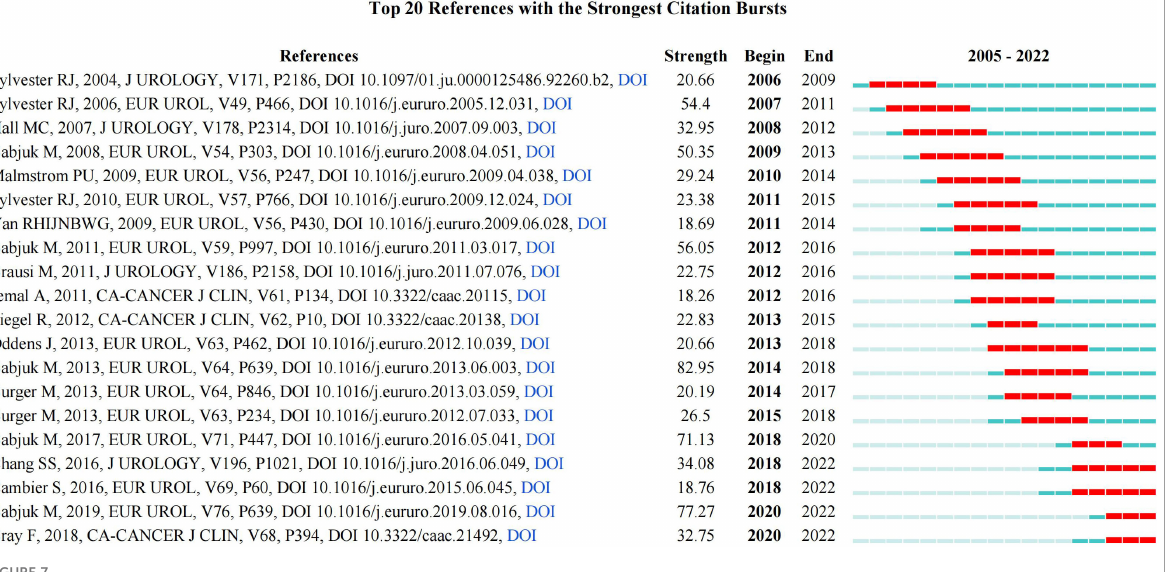
FIGURE 7 References burst analysis by